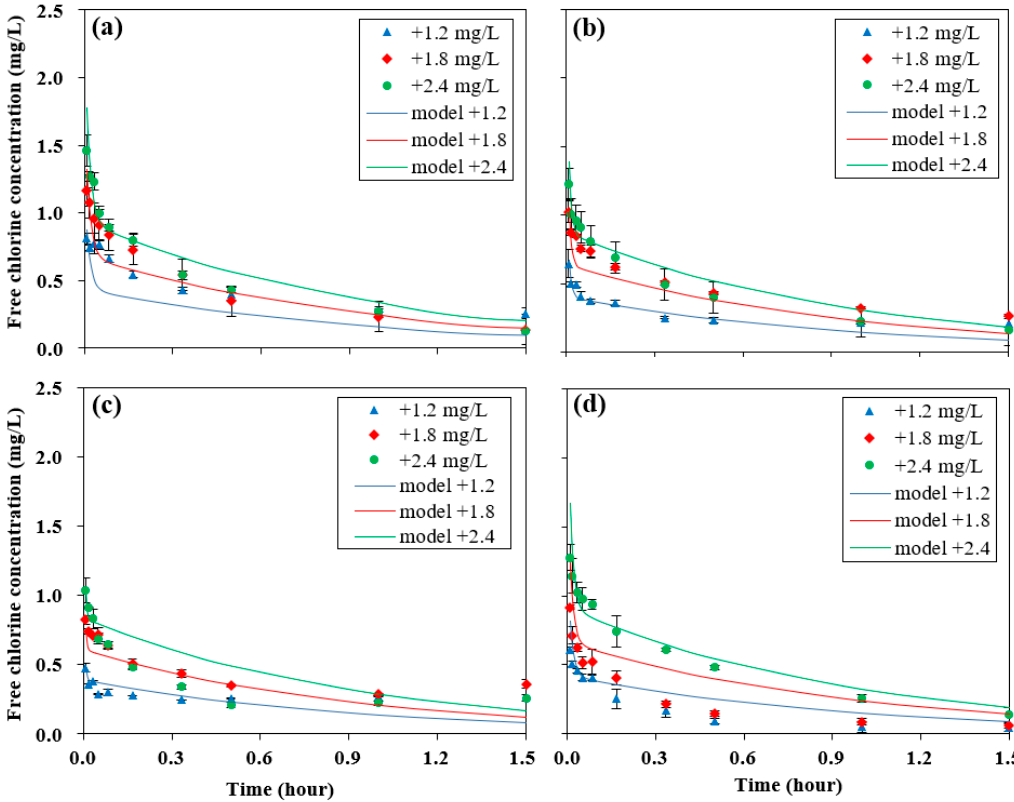
Figure 3. Free chlorine decay curves in seawater with different TOC and initial chlorine concentration. Each line represents the predicted concentration of chlorine under a given condition. ( a ) Artificial seawater solution with 1 mg L − 1 of TOC; ( b ) artificial seawater solution with 2 mg L − 1 of TOC; ( c ) artificial seawater solution with 3 mg L − 1 of TOC; ( d ) West Sea water (1.3 mg L − 1 of TOC).